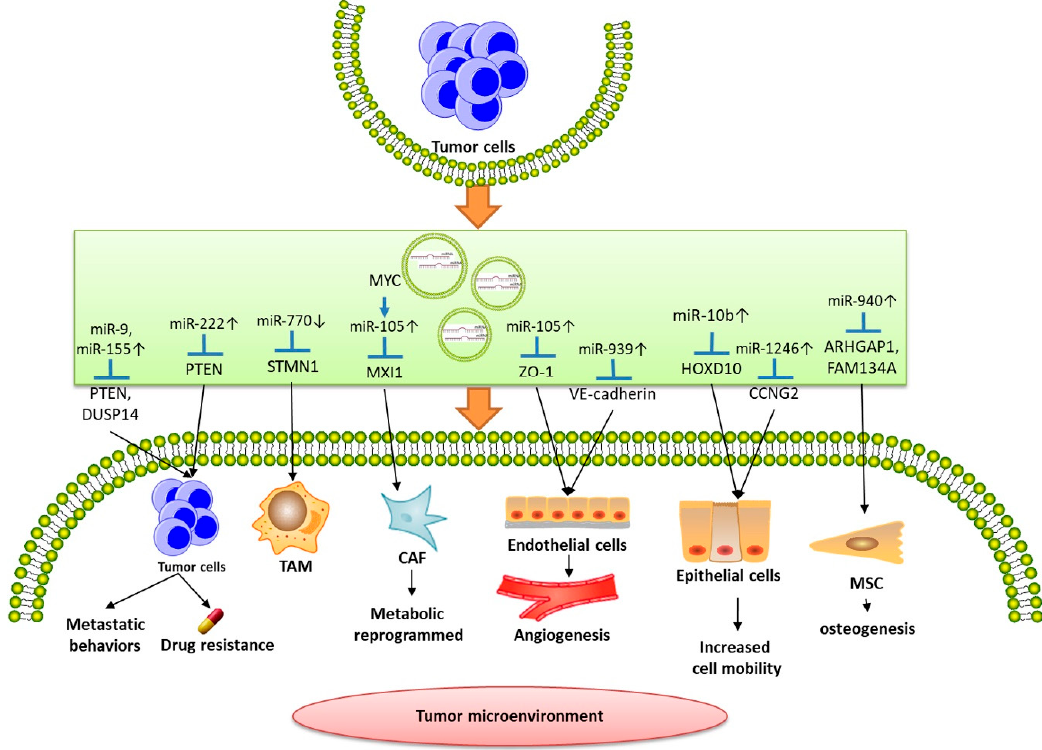
Figure 1. Tumor cells can secrete exosomes which contain diverse microRNAs to modify low-metastatic or non-resistant cancer cells and the stromal cells in the tumor microenvironment such as tumor-associated macrophages (TAMs), cancer-associated fibroblasts (CAFs), endothelial and epithelial cells, mesenchymal cells (MSCs) for their own advantage.